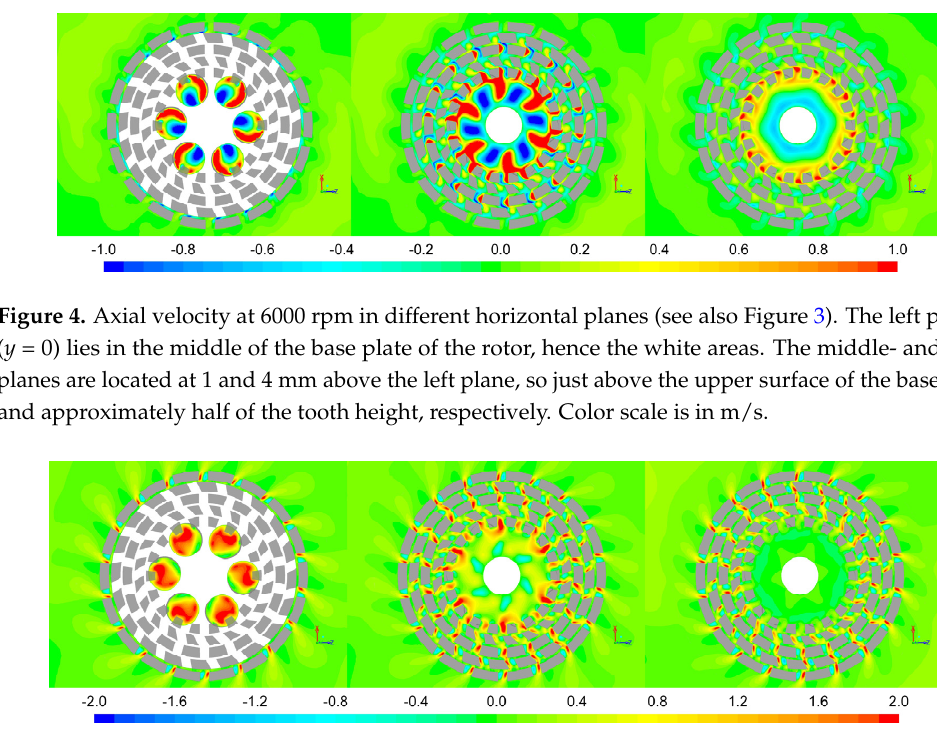
Figure 5. Radial velocity at 6000 rpm for the same planes as in Figure 4. Color scale is in m/s.